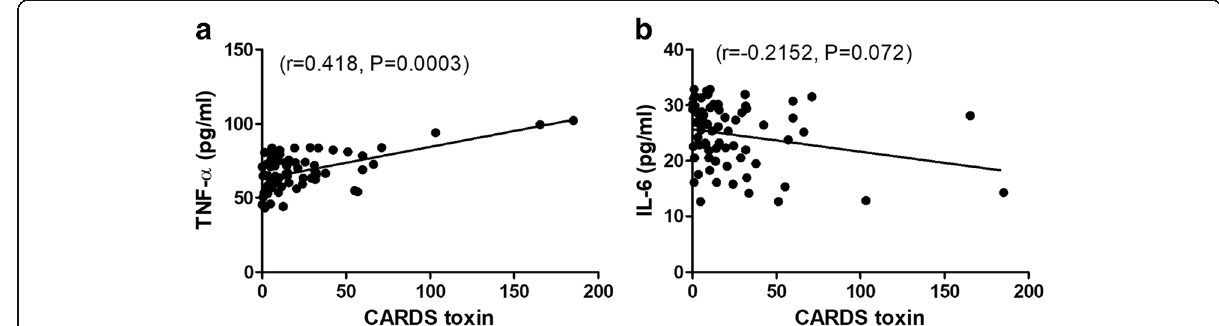
Fig. 2 CARDS toxin was positively correlated with TNF- α level in BALF. The positive correlation between CARDS toxin and TNF- α ( a ), and a negative correlation between CARDS toxin and IL-6 in BALF from children with MPP ( b